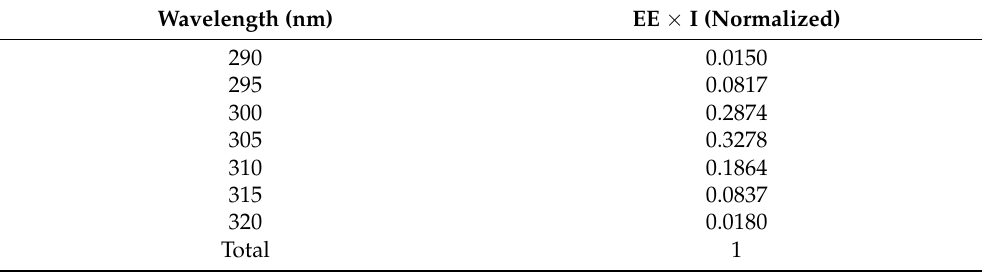
Table 9. Relationship between erythemogenic effect and radiation